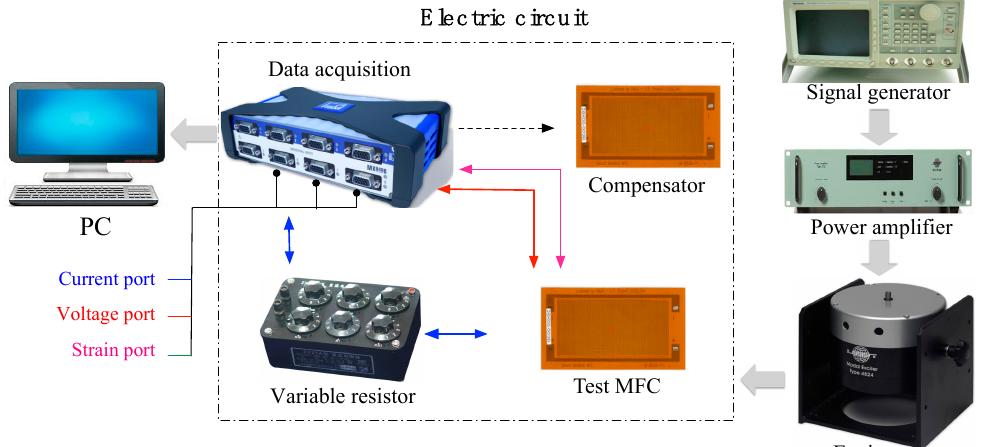
Figure 2. Flowchart for the energy harvesting system with MFC cantilever patch.